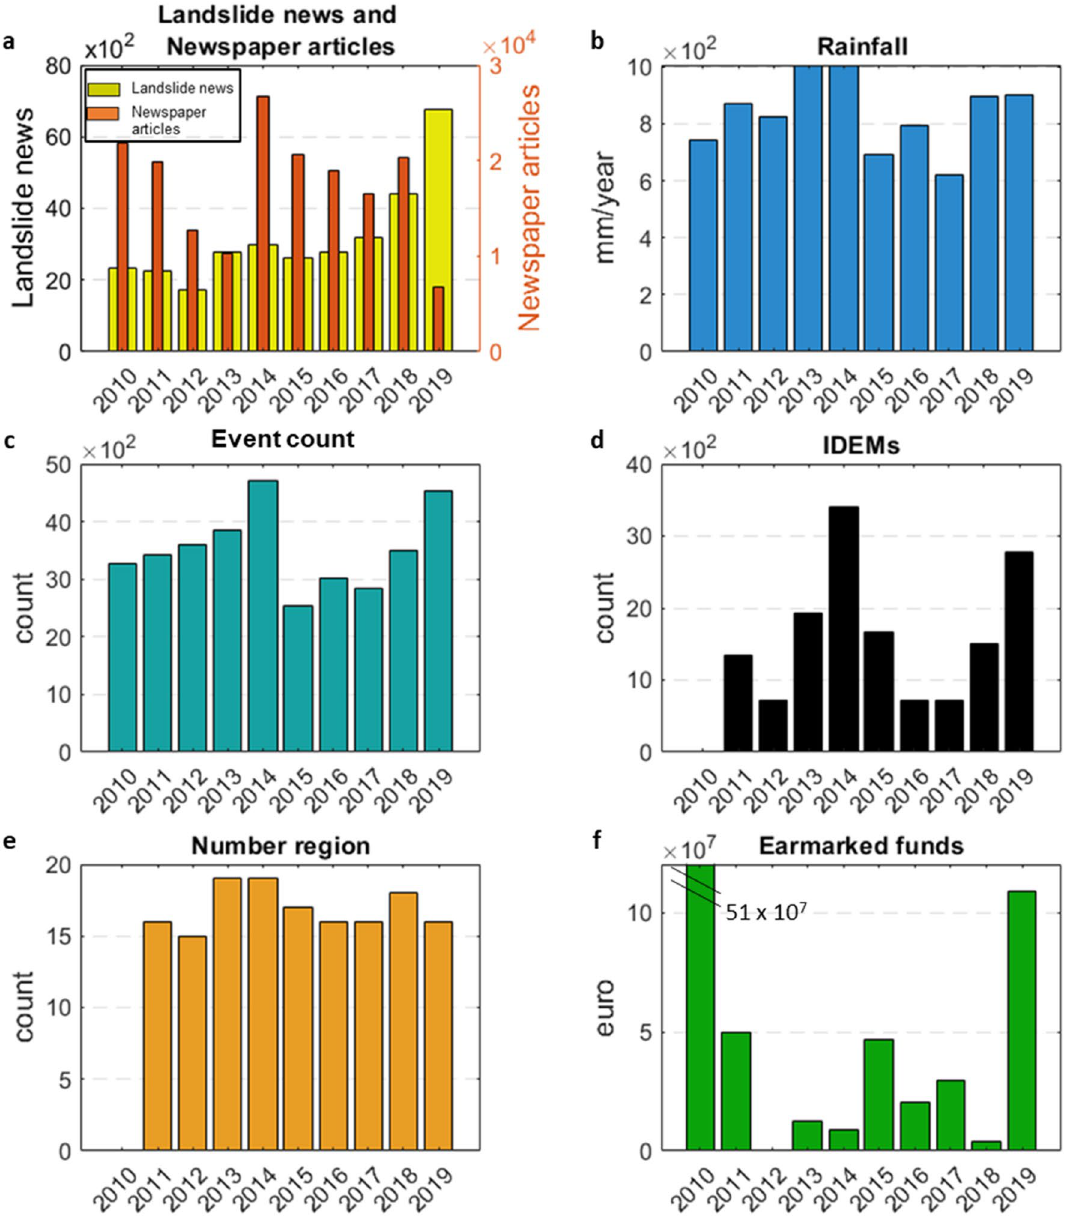
Figure 4. Temporal distribution with different information: ( a ) “Landslide news” and “newspaper articles” from social media. ( b ) Rainfall data with mm/y and in ( c ) event count. ( d ) Polaris with IDEMs (injured, death, evacuated and missing) number. ( e ) Involved region. ( f ) Earmarked funds for soil protection (euro—ReNDiS with focus for better